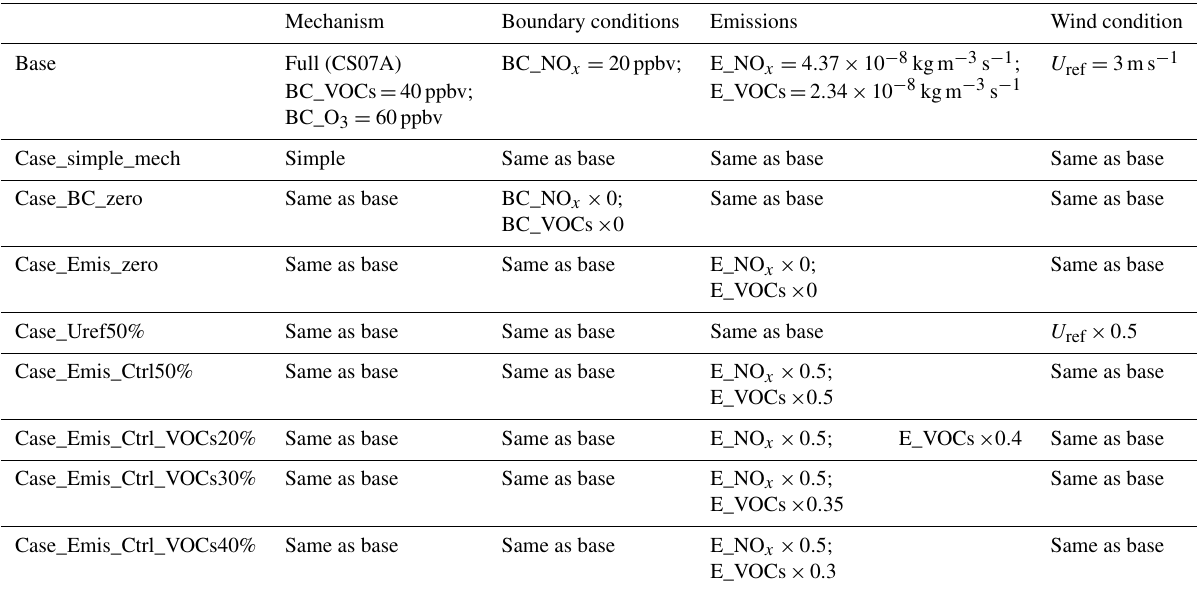
Table 5. Description of all simulation cases. Mechanism Boundary conditions Emissions Wind